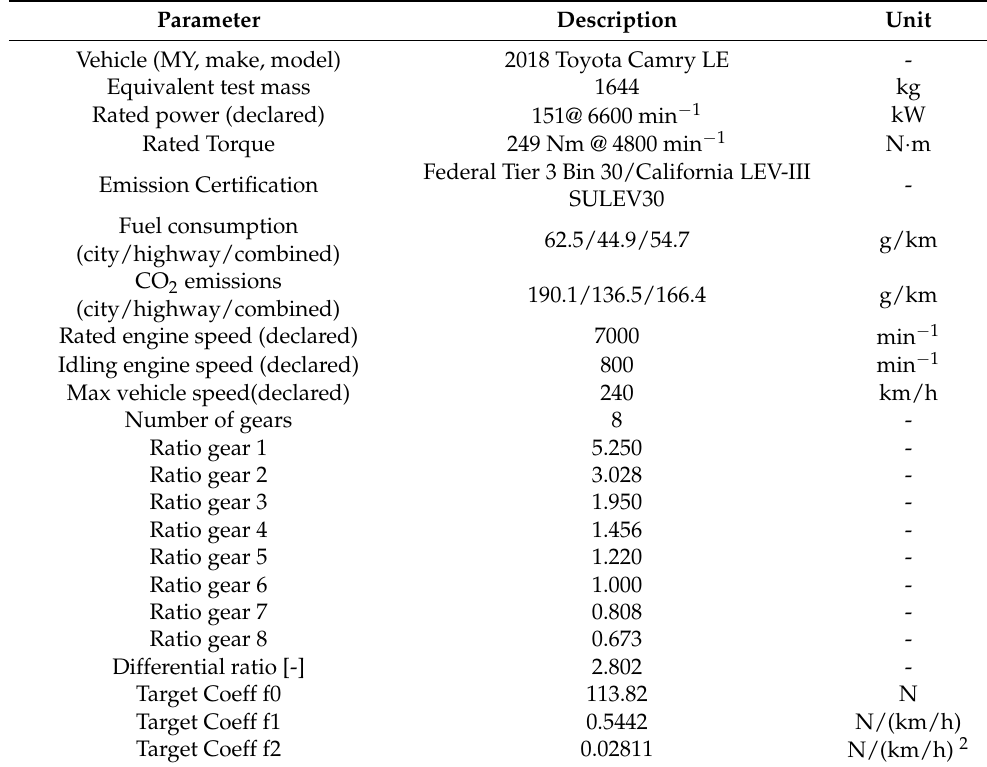
Table 2. Parameters of the vehicle used in the research for driving tests